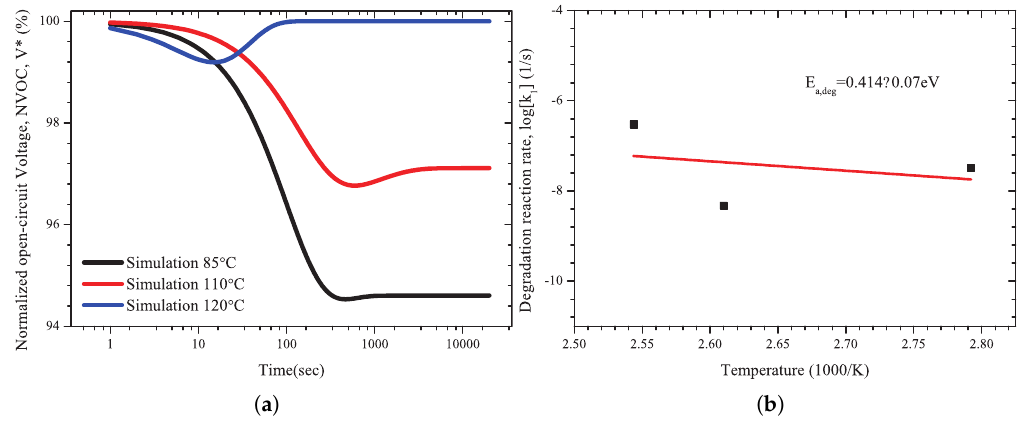
Figure 5. ( a ) Real-time regeneration application observation results and fitting dynamic simulation results of PERC solar cell module. ( b ) Rate constant distribution results by temperature for extracting LID activation energy generated during experiment on applying regeneration state to PERC solar cell